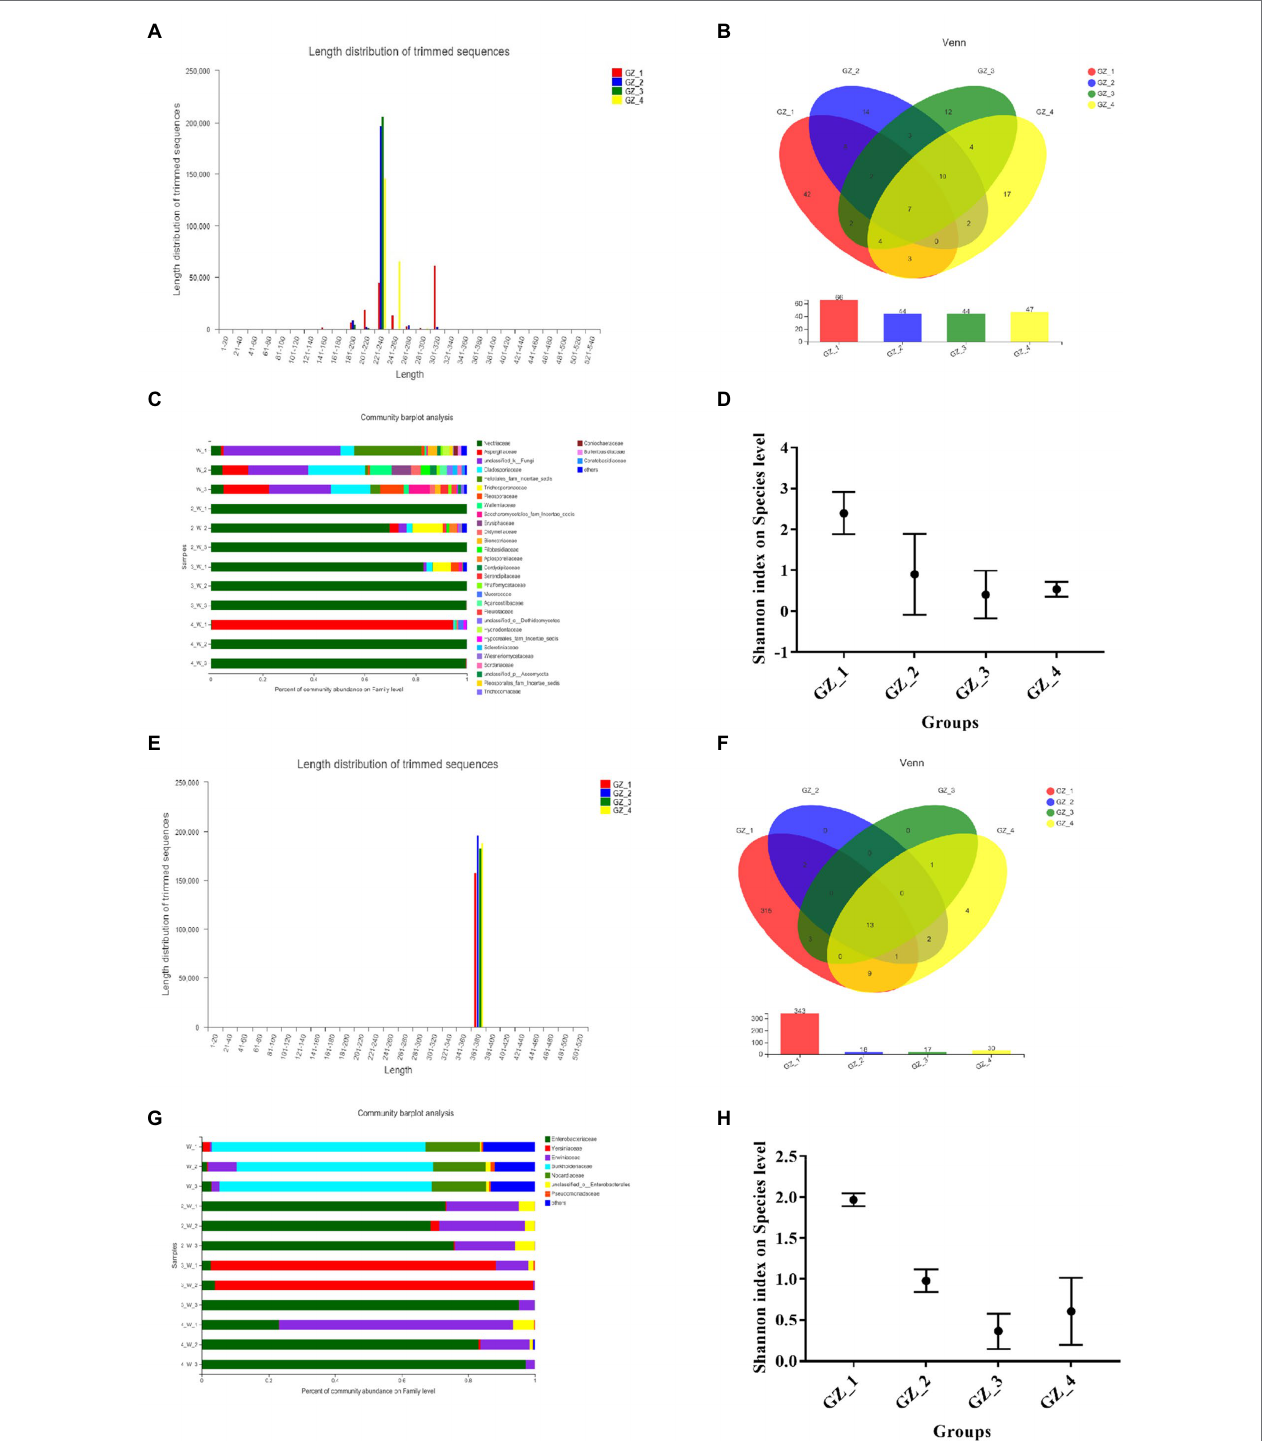
FIGURE 2 | Structural characteristics of the endophytic microbial community of licorice during the natural drying process (GZ_1: fresh licorice; GZ_2: early drying: 6 days after drying; GZ_3: mid-drying: 12 days after drying; and GZ_4: complete drying: 18 days after drying. Each sample was made by mixing five licorice roots). (A) The distribution range of the sequence length of endophytic fungi. (B) Venn diagram of endophytic fungi in different groups. (C) Endophytic fungal community composition. (D) Shannon index at the level of endophytic fungal species in different groups. (E) The distribution range of the length of the endogenetic bacteria sequencing sequence. (F) Venn diagram of endophytic bacteria in different groups. (G) Endophytic bacterial community composition. (H) Shannon index at the level of different groups of endophytic